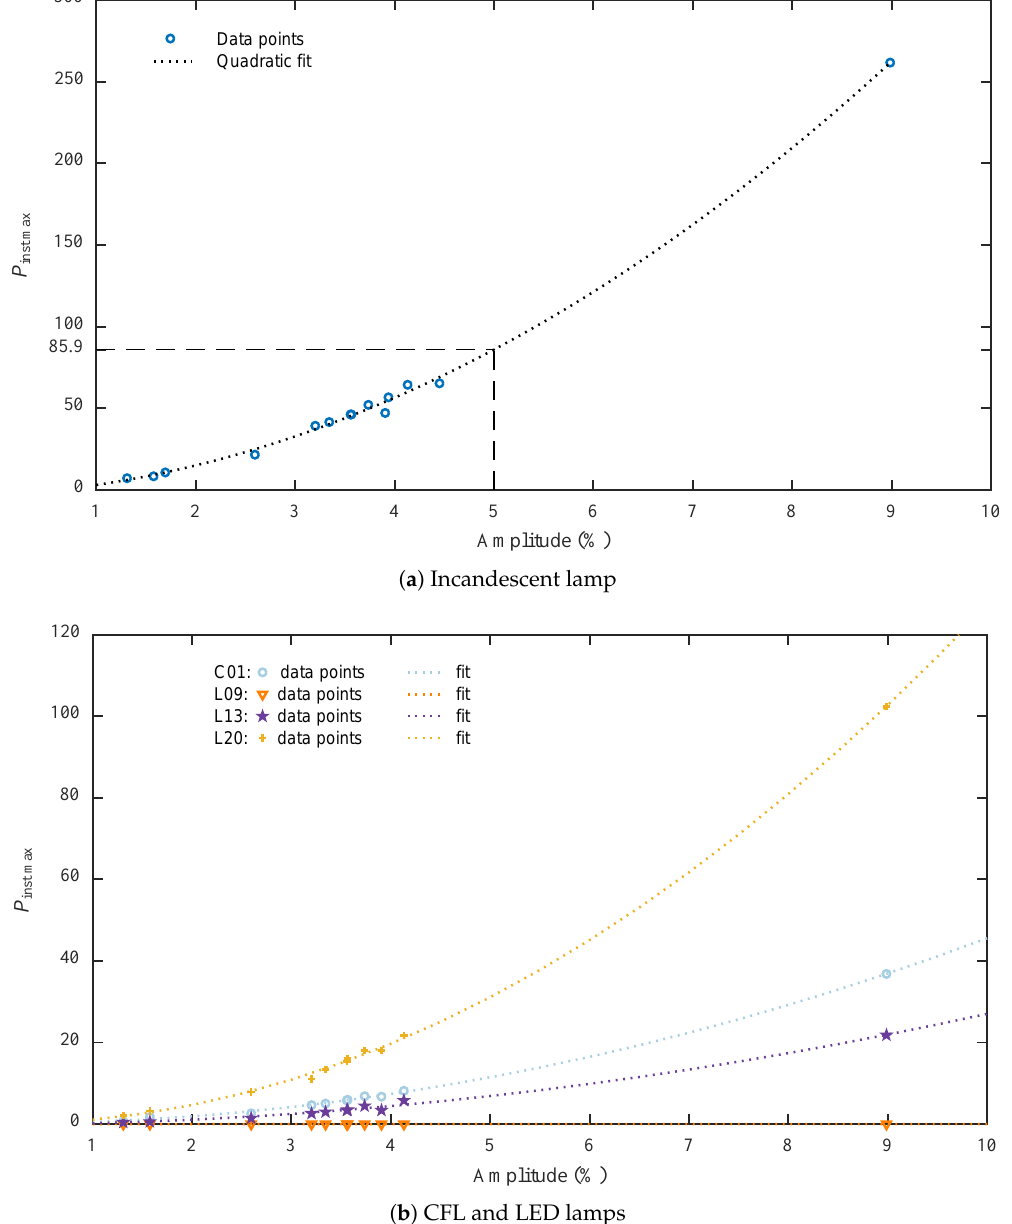
Figure 7. Response of the incandescent lamp ( a ) and CFL and LED lamps ( b ) to instantaneous ramp type